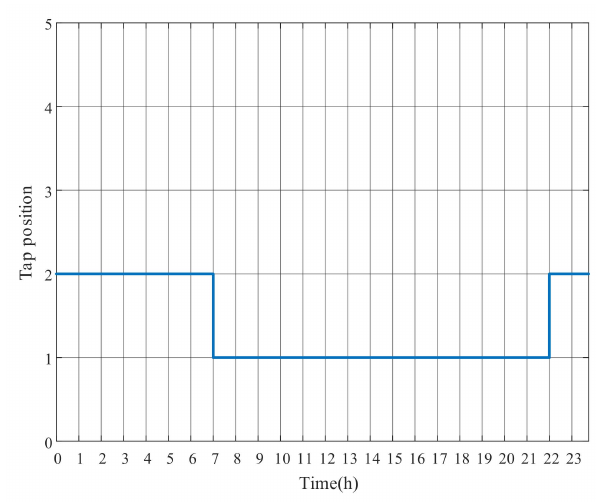
Figure 19. OLTC tap changes with DRM strategy of Case 2.